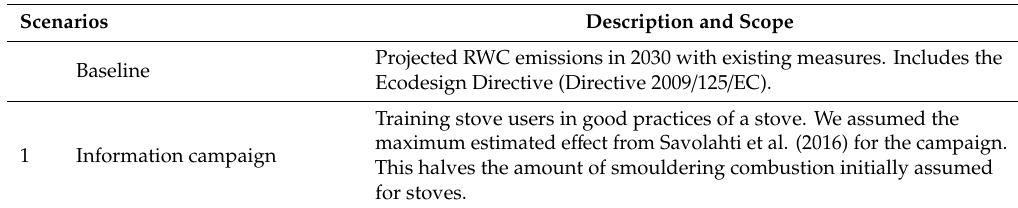
Table 1. Residential wood combustion (RWC) emission reduction measures in the studied scenarios. The scenarios from 1 to 4 have been applied